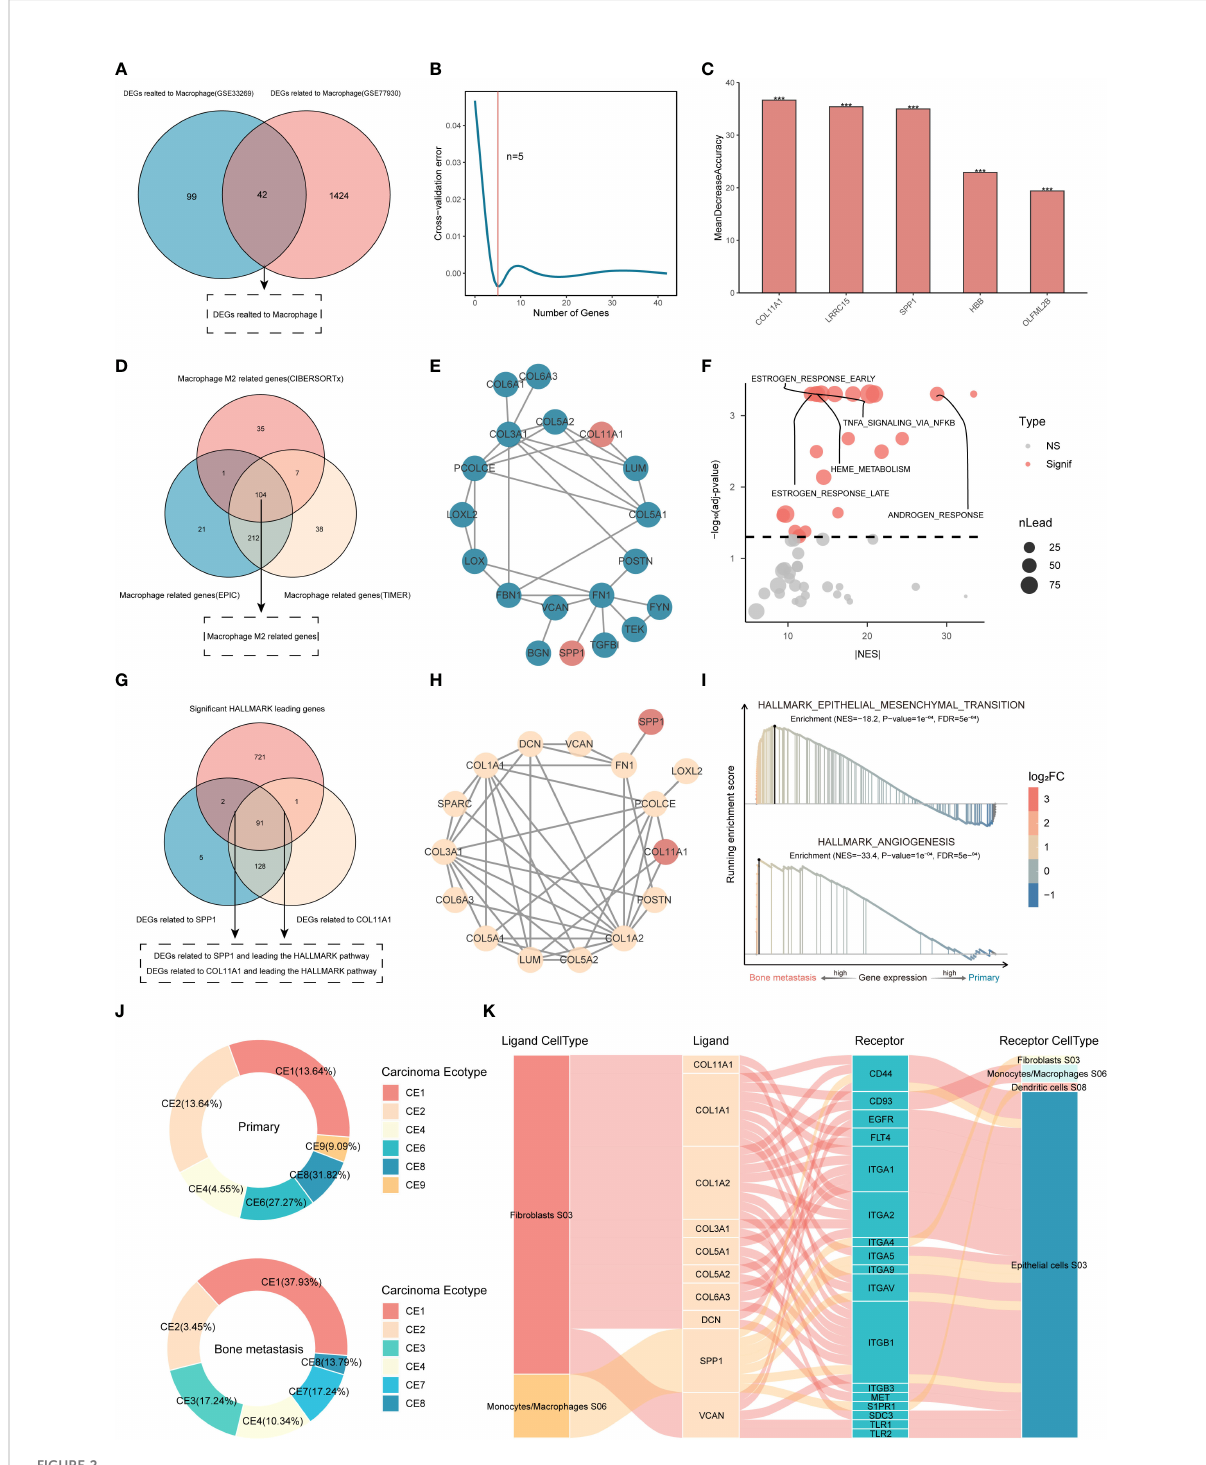
FIGURE 2 Identi fi cation of genes characteristic of M2 macrophage-associated BMs. (A) Macrophage-related DEGs. (B, C) Key gene identi fi cation based on random forest. ***P<0.001. ns, not signi fi cant. (D) Analysis of M2 macrophage-related DEGs based on WGCNA. (E) PPI between DEGs of BMs and M2 macrophage-related genes. (F) GSEA of SPP1 and COL11A1 proteins. (G, H) PPI analysis between proteins in enrichment pathways and key proteins. (I) GSEA of kernel targets. (J, K) Cancer ecotype analysis and cellular distribution of ligands and